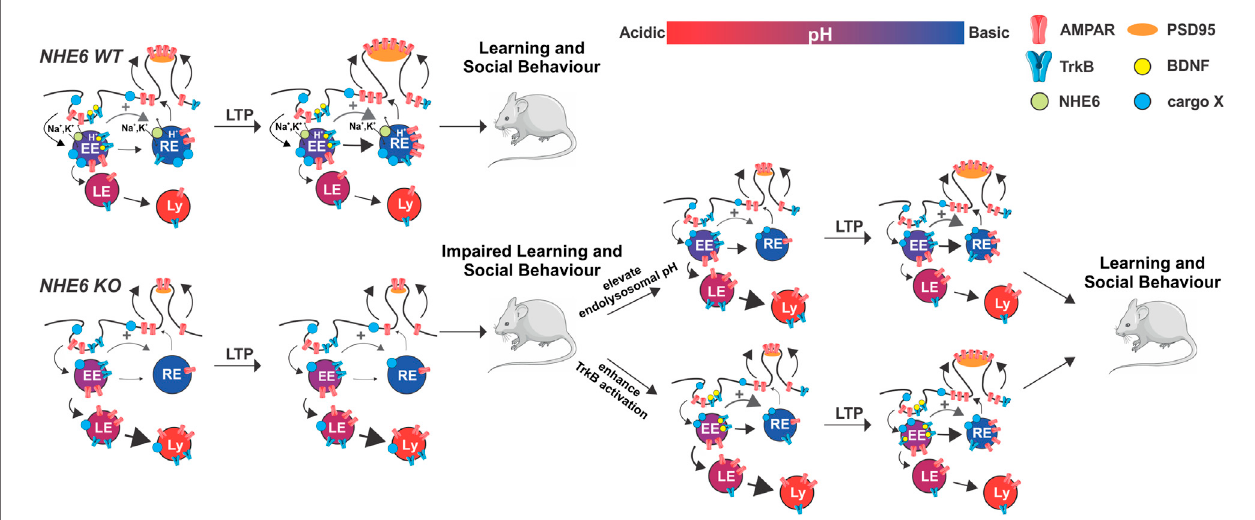
FIGURE3| SchematicofimpairedendosomalpHhomeostasisandAMPARandTrkBtraf fi ckingleadingtodefectivesynapticpotentiationandbehaviourallearning in NHE6 KO versus WT mice. Potential treatment strategies (i.e., elevate endolysosomal pH, enhance TrkB activation) to address these de fi ciencies in KO are indicated. Thickness of arrows represents relative extent of AMPA transport (black) or TrkB receptor signaling (gray). EE, early endosome; RE, recycling endosome; LE, late endosome; Ly, lysosome; BDNF, brain-derived neurotrophic factor; PSD95, postsynaptic density protein-95; cargo X, unde fi ned membrane cargo.